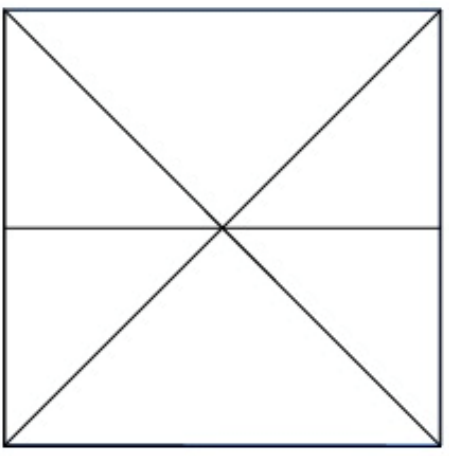
Figure 1. Count the triangles.